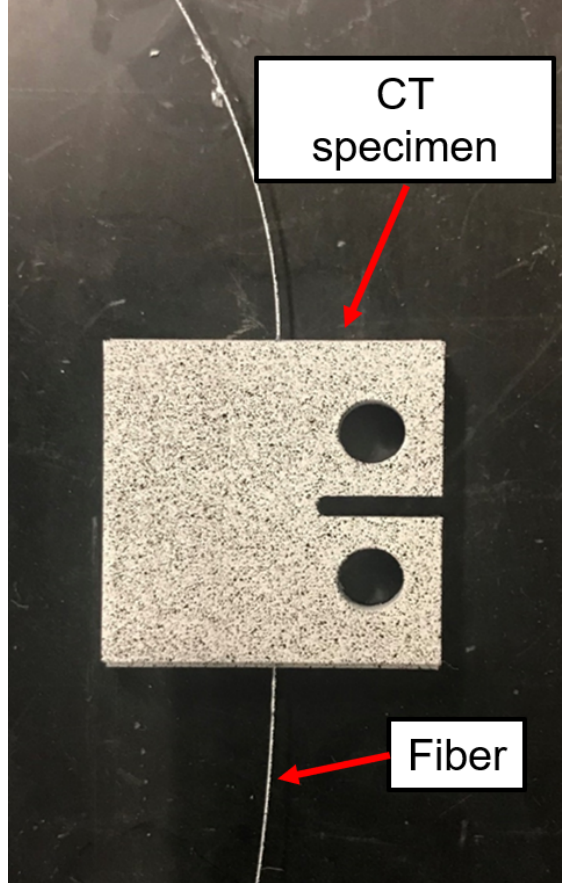
Figure 5. Compact tension (CT) specimen with one embedded FBG sensor built using UAM used in crack initiation and strain tracking. A fine speckle has been applied for DIC tracking. The FBG sensor is located 3 mm from the tip of the